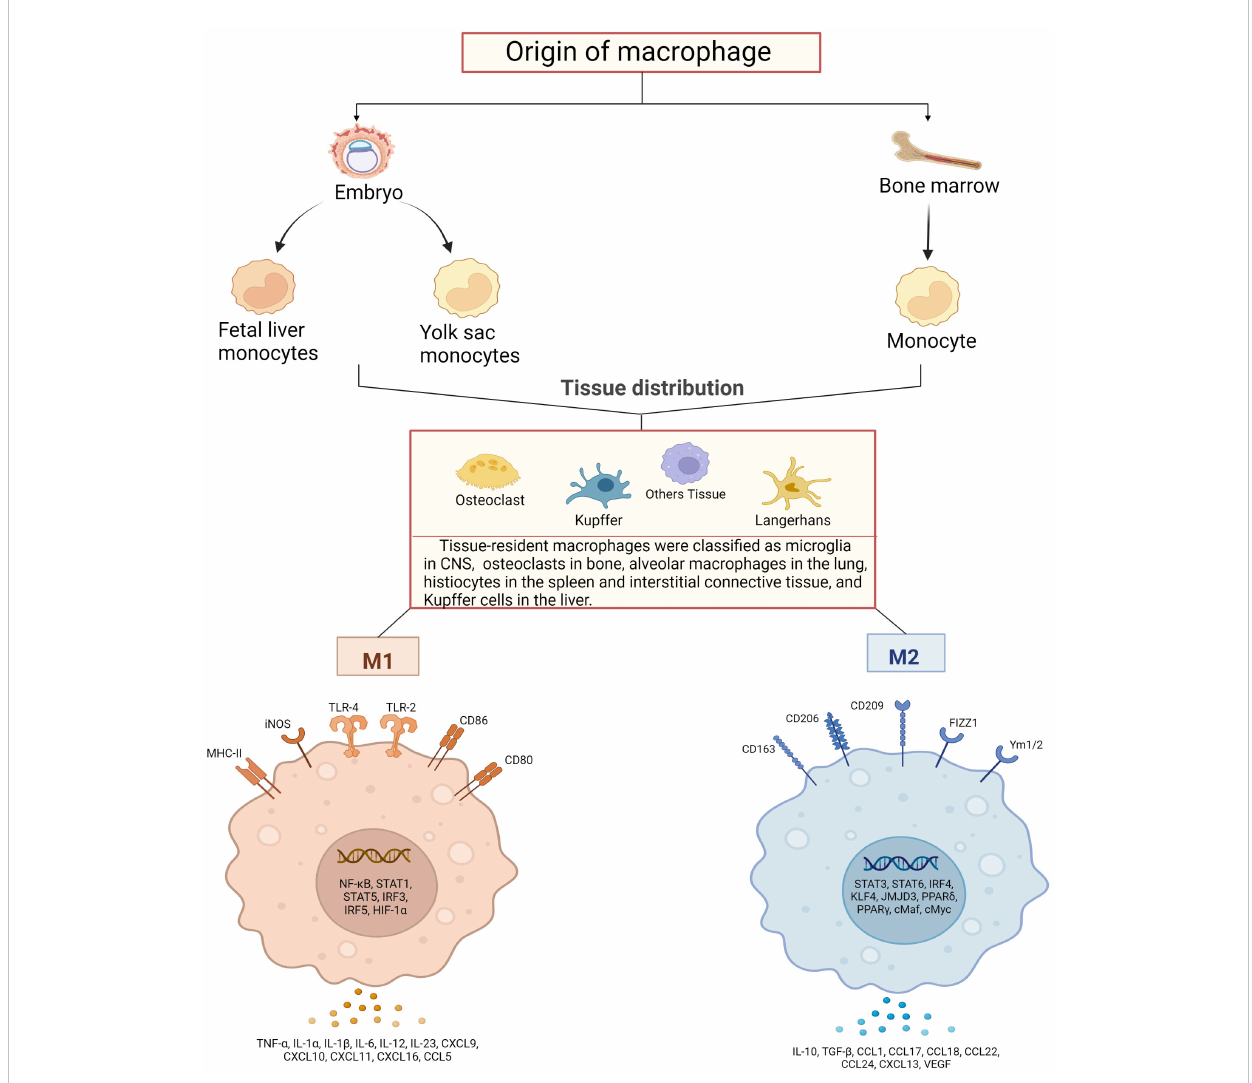
FIGURE 1 Schematic diagram of macrophage sources, distribution and their activation. Macrophages are derived from bone marrow and embryonic stem cells, and some bone marrow-derived monocytes subsequently fl ow into tissues to develop into tissue-resident macrophages together with embryonic hepatocytes and yolk sac cells, and speci fi cally differentiate into different functional macrophages at different sites. They have in common that both can polarize into pro-in fl ammatory (M1) and anti-in fl ammatory (M2) phenotypes. M1-type macrophages are activated by TLRs ligands and involve several transcription factors, such as NF- k B, STAT1, STAT5, IRF3, IRF5 and HIF-1 a , while releasing pro-in fl ammatory and chemokines including TNF- a , IL-1 a , IL-1 b M2 macrophages activate transcription factors including STAT3, STAT6, IRF4, KLF4, JMJD3, PPAR d , PPAR g and release